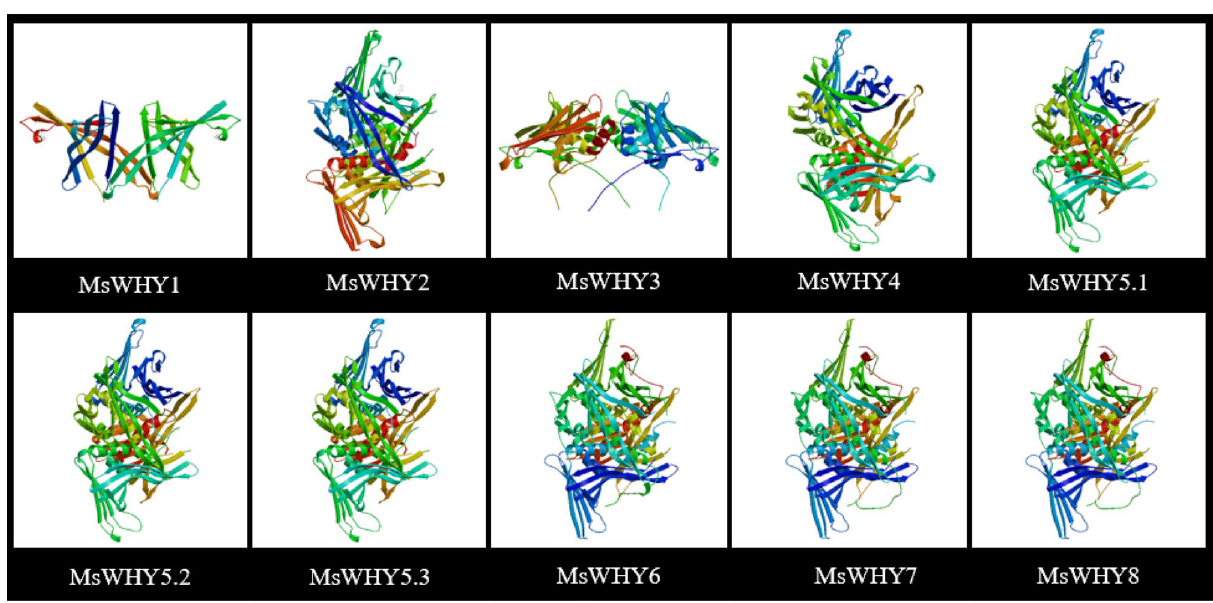
Figure 7. Three-dimensional structures of MsWHY